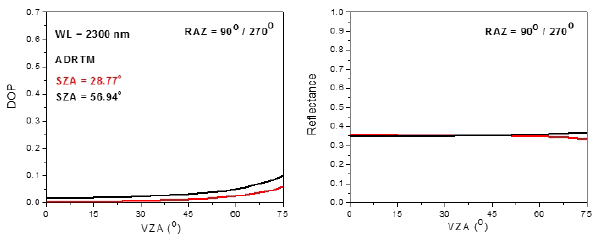
Figure 24. Same as in Fig. 23 but at RAZs of 90 and 270 ◦ .